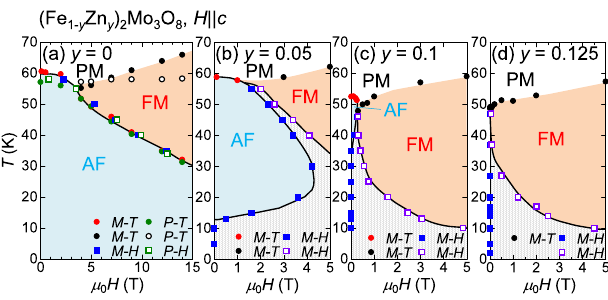
FIG. 3. (a – d) The H - T phase diagrams for ð Fe 1 − with various values of y under H ∥ c , as determined by M and P measurements. PM, AF, and FM indicate the paramagnetic, antiferromagnetic, and ferrimagnetic phases, respectively. Shaded areas indicate hysteretic regions.